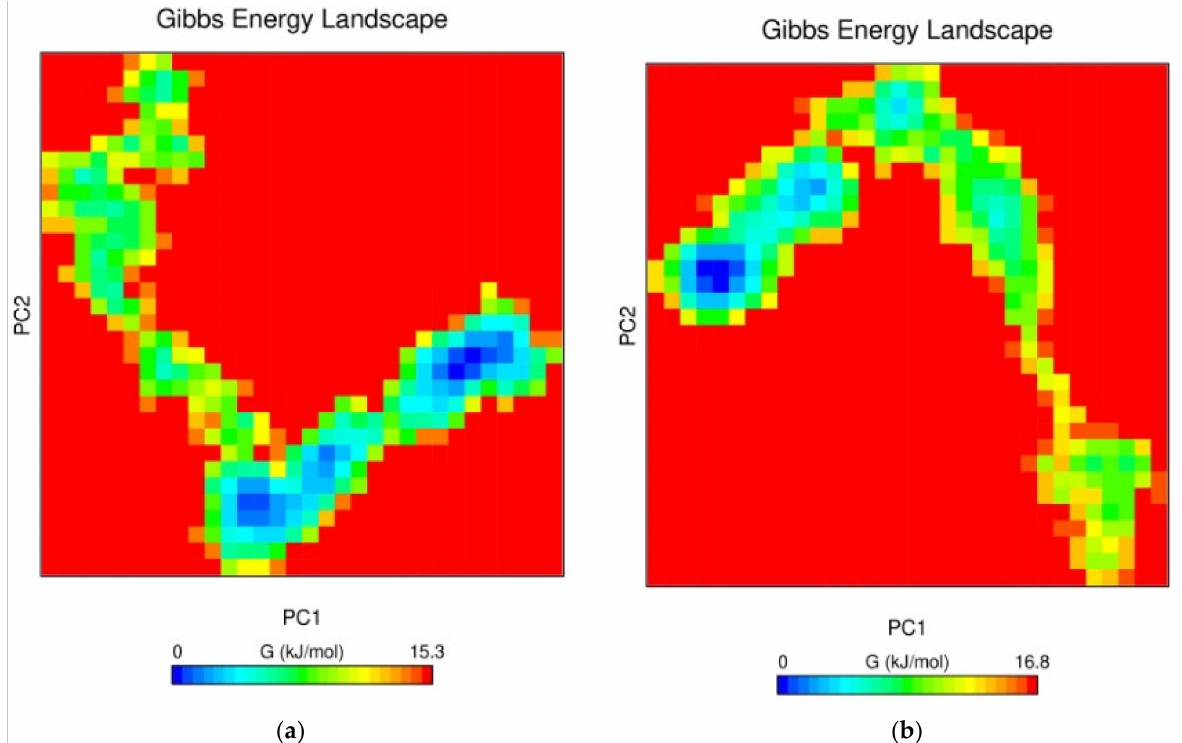
Figure 9. Free energy landscape of ( a ) ACCase–fenoxaprop-p-ethyl and ( b ) ACCase–sinigrin